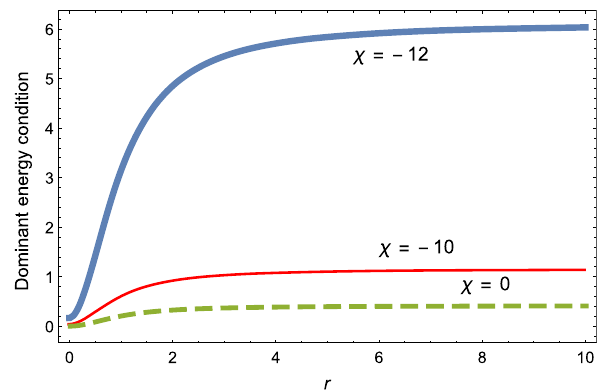
Fig. 6 Dominant energy condition versus radial value r